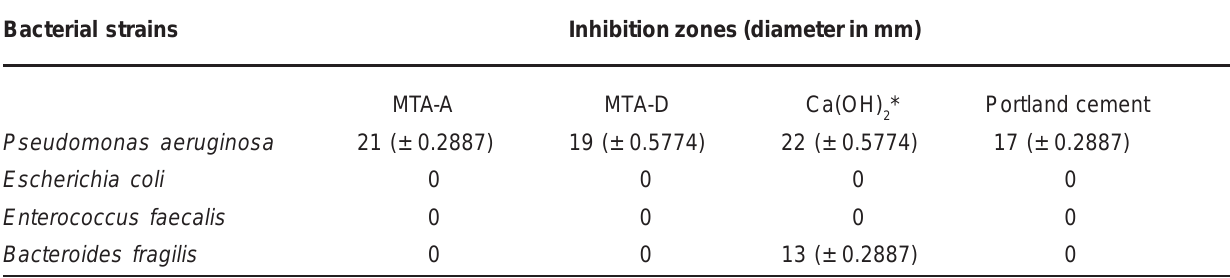
TABLE 1- Antimicrobial activity of MTA-Angelus (MTA-A), MTA- Dentsply (MTA-D), Calcium hydroxide (Ca (OH) cement